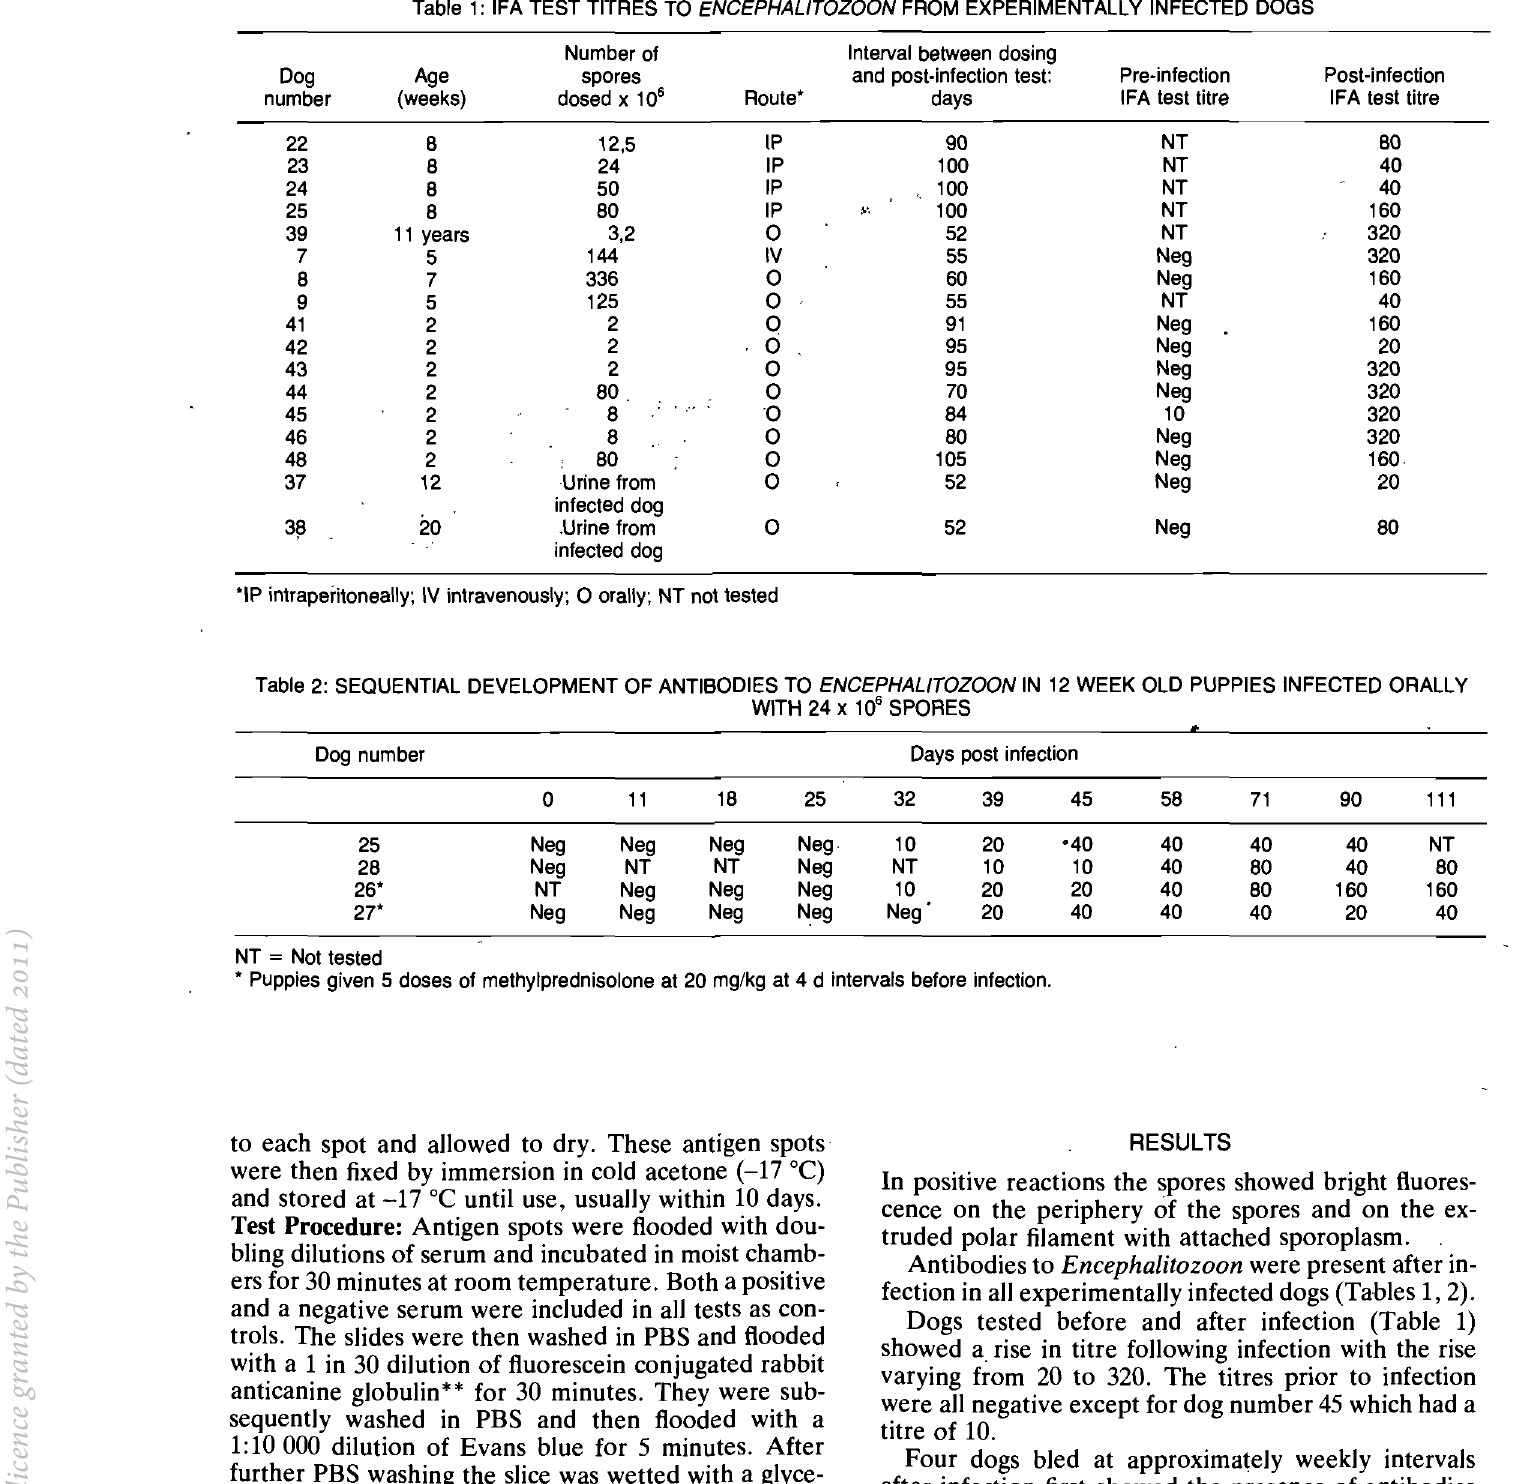
Table 1: IFA TEST TITRES TO ENCEPHALITOZOON FROM EXPERIMENTALLY INFECTED DOGS Number of InteNal between dosing 22